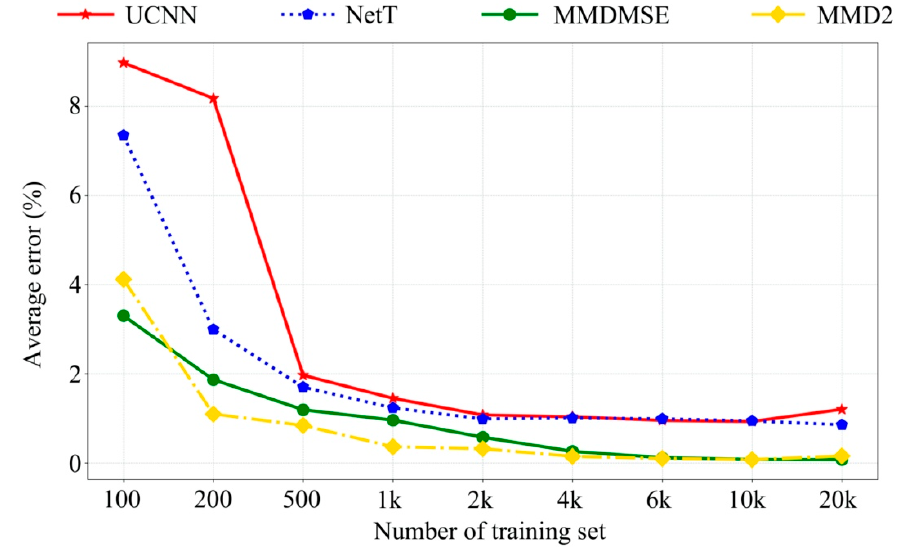
Figure 7. Average error with increasingly number of training set. The FR signal of the No.1 sampling location with increasing training sample size is plotted